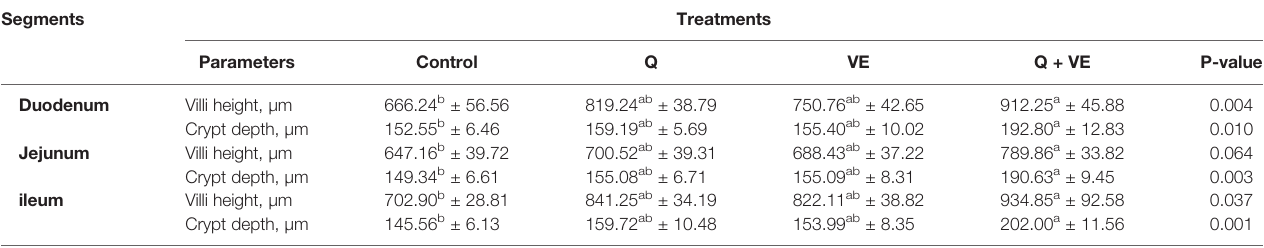
TABLE 5 | Duodenal, jejunal, and ileal morphological characteristics of aged breeder chickens fed with Q, VE, and Q + VE. Segments